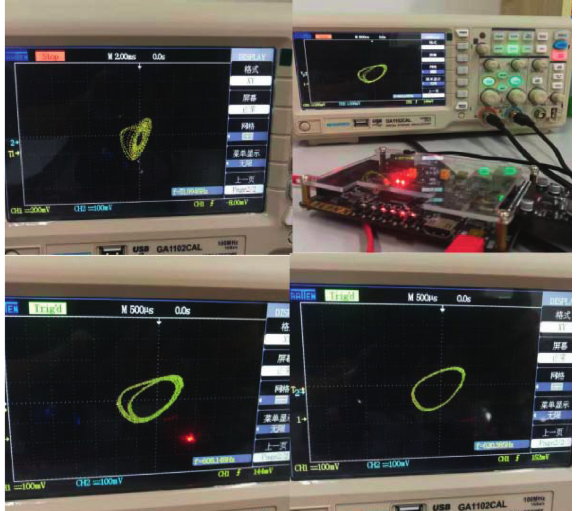
Figure 20: Implementation platform and exemplification of the single band chaotic attractor and period limit cycles generated by the FPGA implementation of the multistable modified fourth-order Chua’s chaotic